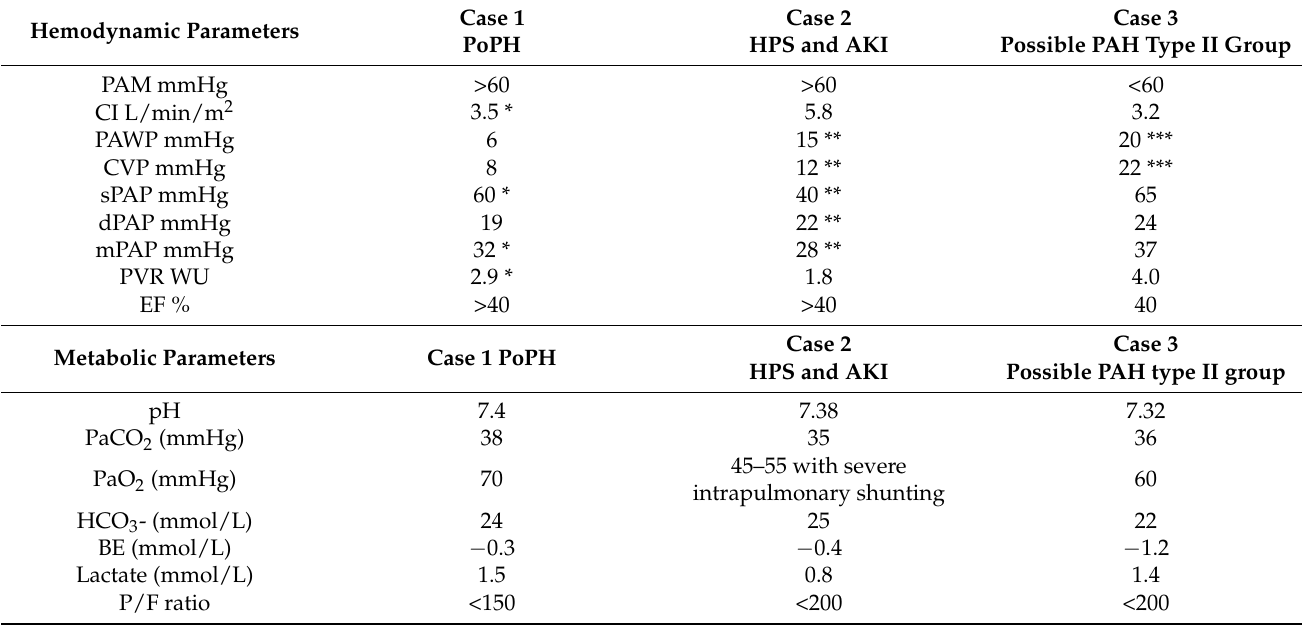
Table 1. Summary of hemodynamic and metabolic